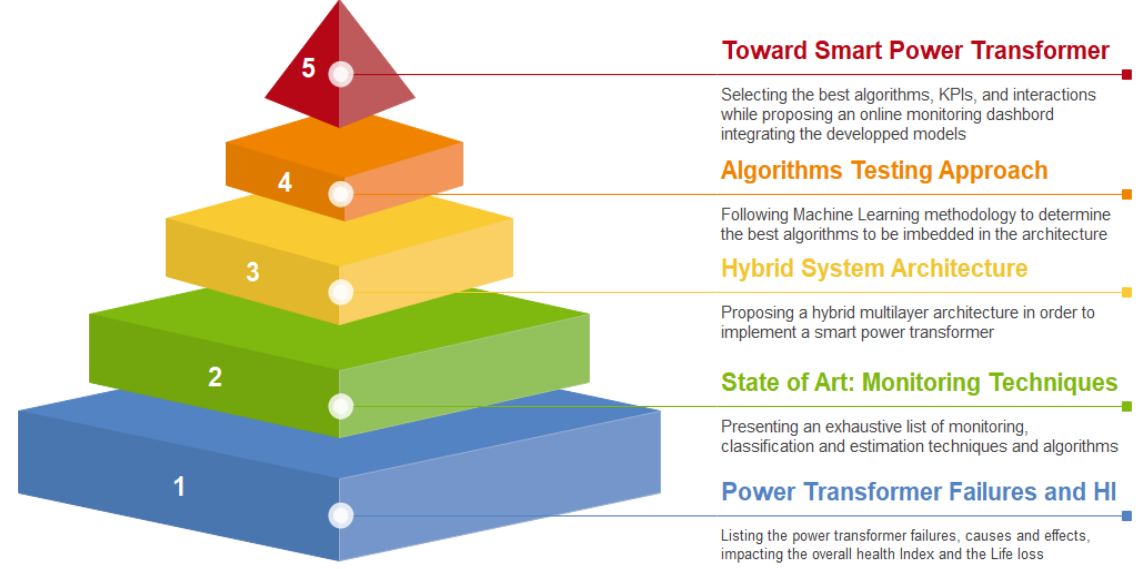
Figure 2. Paper structure.